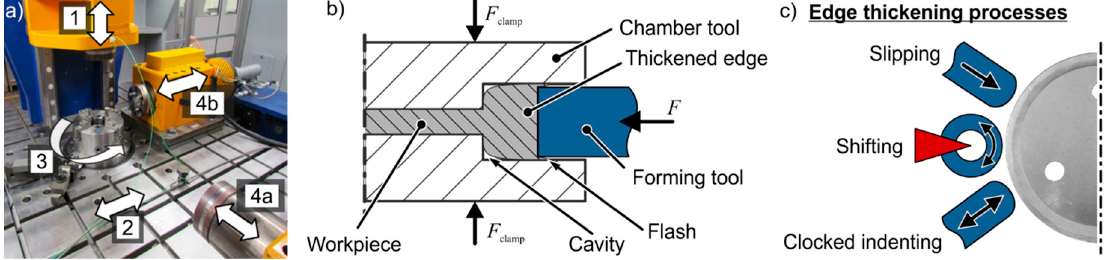
Figure 3. ( a ) Multi-axis forming press and ( b ) schematically cross-section of the edge thickening by ( c ) different edge thickening processes. ( c ) di ff erent edge thickening